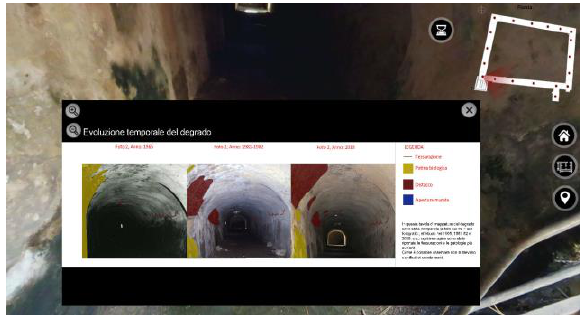
Figure 12. Visualisation of a diagnostic datasheets in the